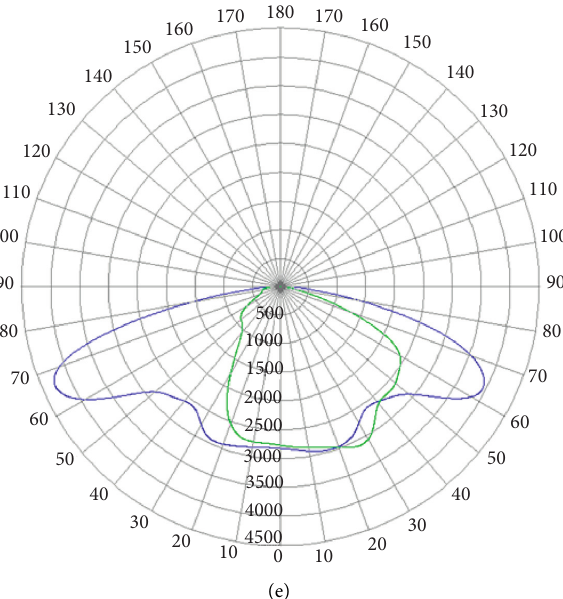
Figure 10: Simulated light distribution curves with bulb placed (a) 5mm up (5, 0, 0); (b) 5mm down ( − 5, 0, 0); (c) 5mm left (0, 5, 0); (d) 5mm right (0, − 5, 0); (e) in the optimal position [6].